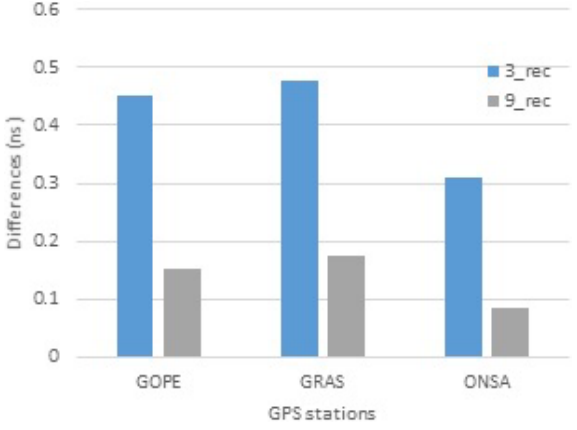
Figure 5. Mean difference between the receiver DCB values of the IGS and the computed values by MSDCBE estimated from 1 to 5 January